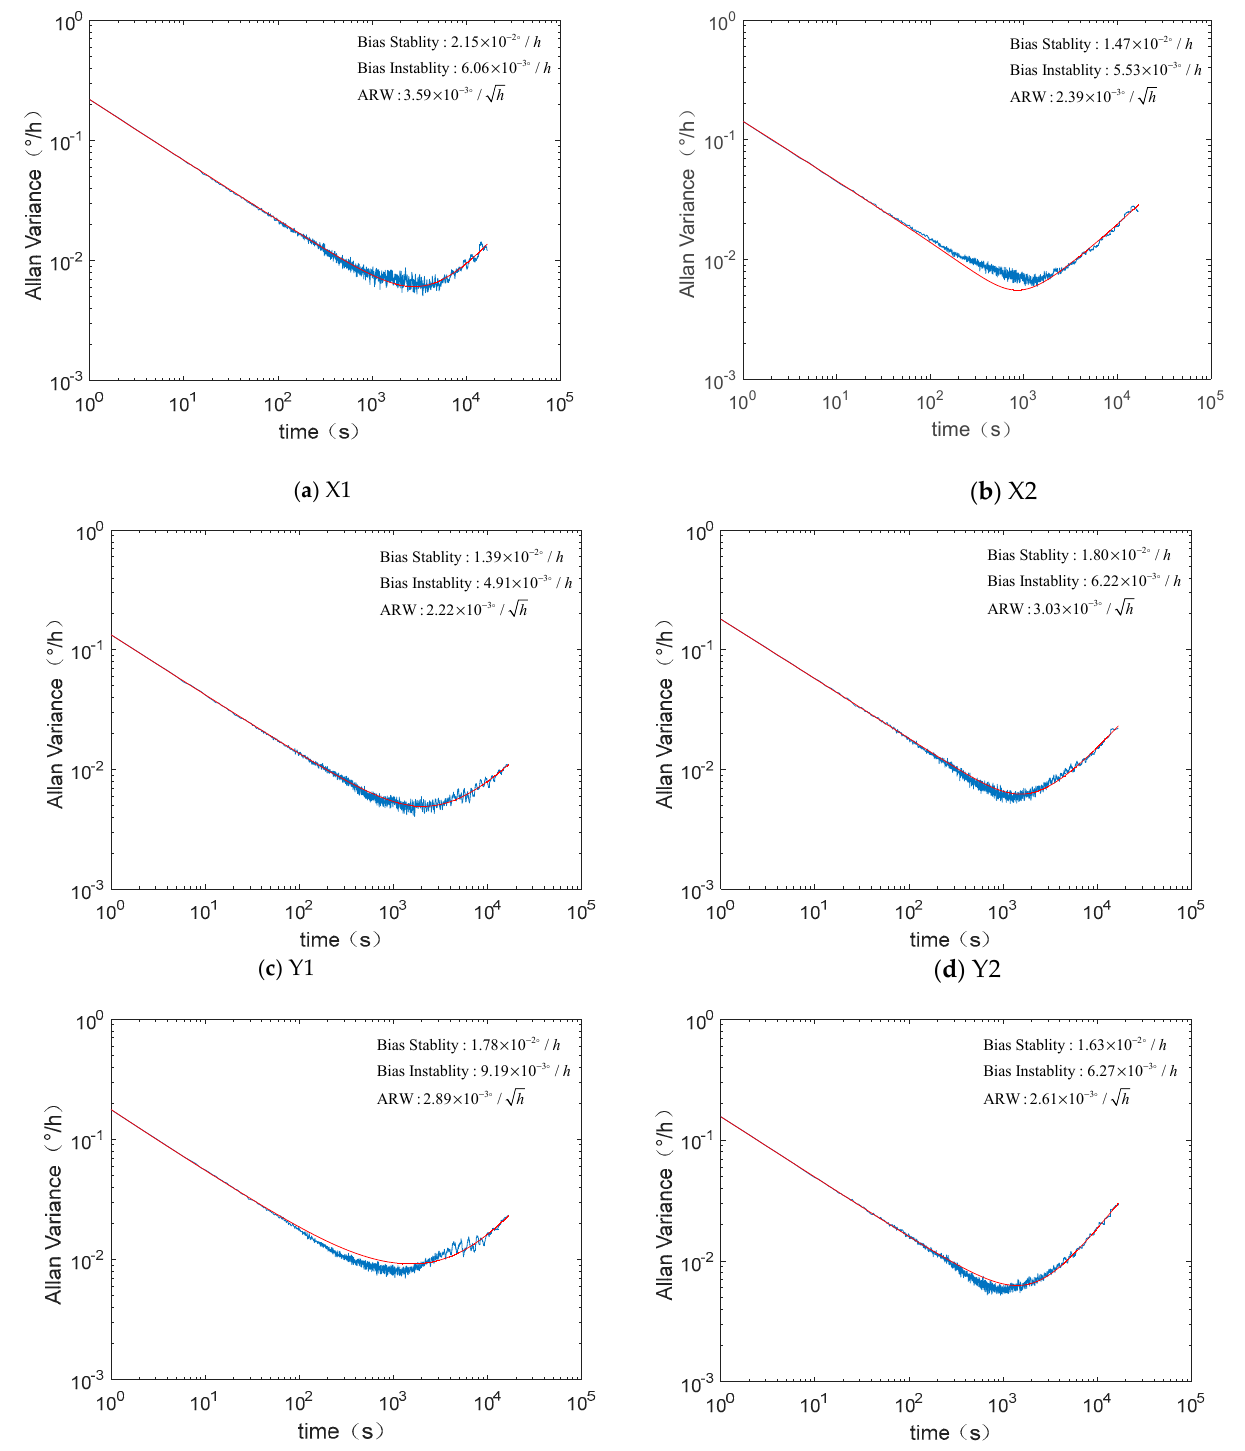
Figure 8. Allan variance curves of the six MEMS gyroscopes in the inertial measurement unit (IMU). The same MEMS IMU was tested for another 24 h, about 4 months later. The data show that the bias offset of the gyroscopes were changed a little, as shown in Table 2, and the Allen variance of the six MEMS gyroscopes are shown in Figure 9. Table 2. Ground test results of the IMU 4 months later.